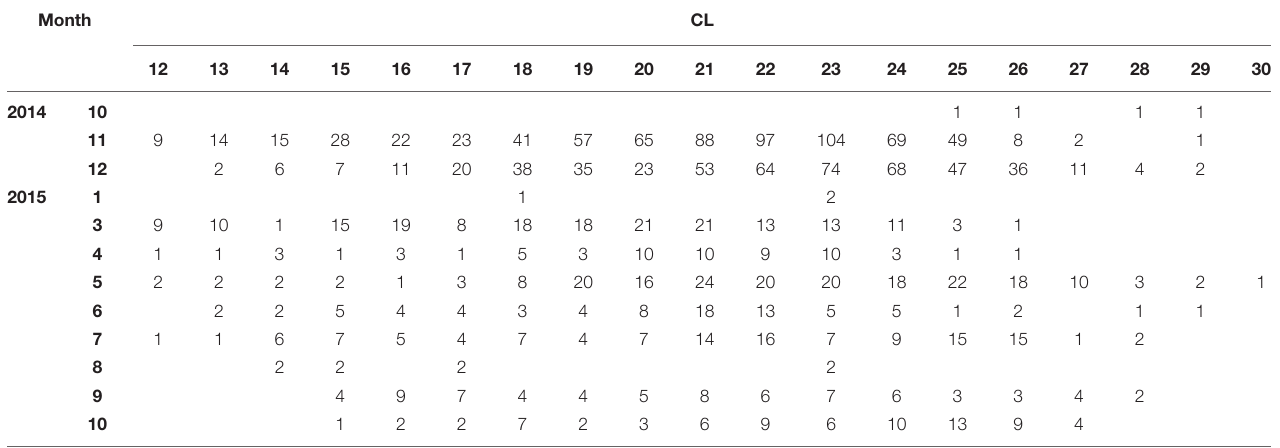
TABLE 1 | Monthly (1: January – 12: December) length frequency of P. edwardsii in SE Aegean Sea during